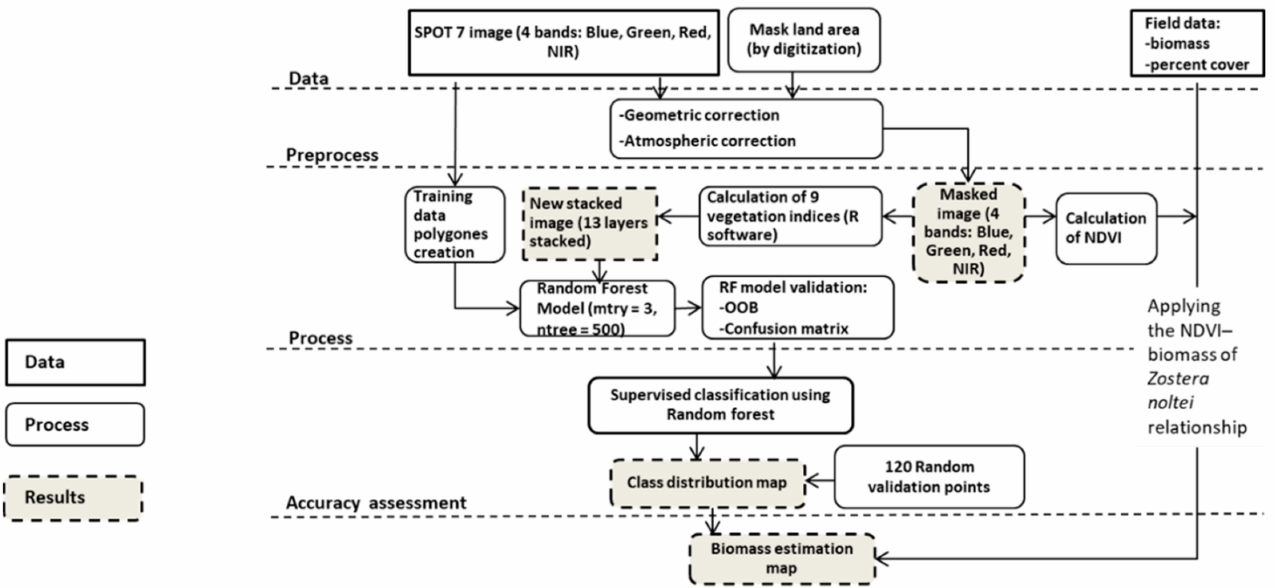
Figure 2. Flowchart of data processing to map dwarf eelgrass Z. noltei and algae in the Merja Zerga